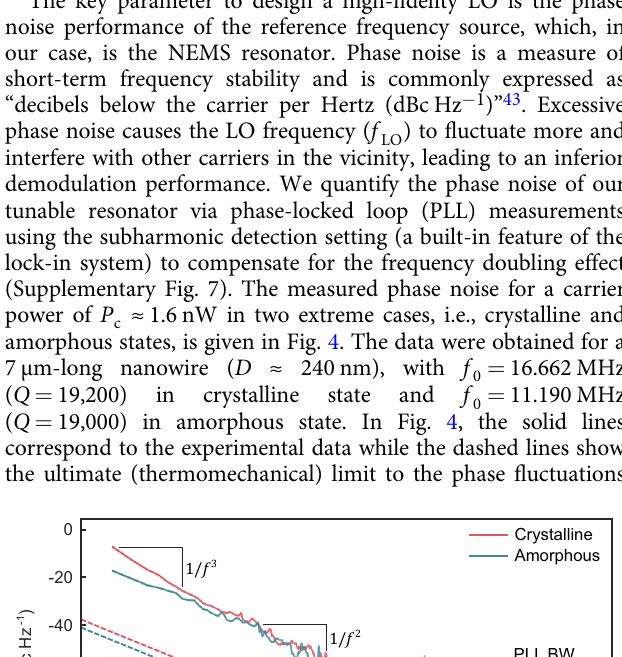
( Q = 19,000) in amorphous state. In Fig. 4, the solid lines correspond to the experimental data while the dashed lines show the ultimate (thermomechanical) limit to the phase fl uctuations